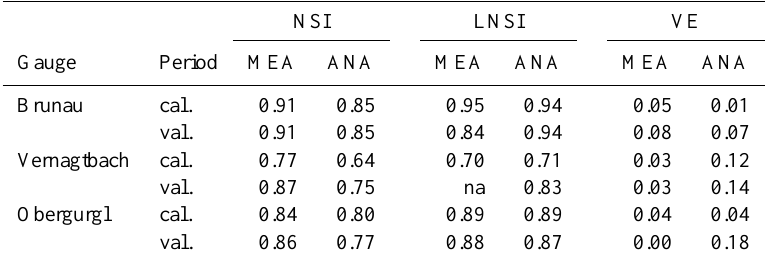
Table 1. Goodness measures (NSI, LNSI, VE) of calibrated model for calibration period (cal.) and validation period (val.) using